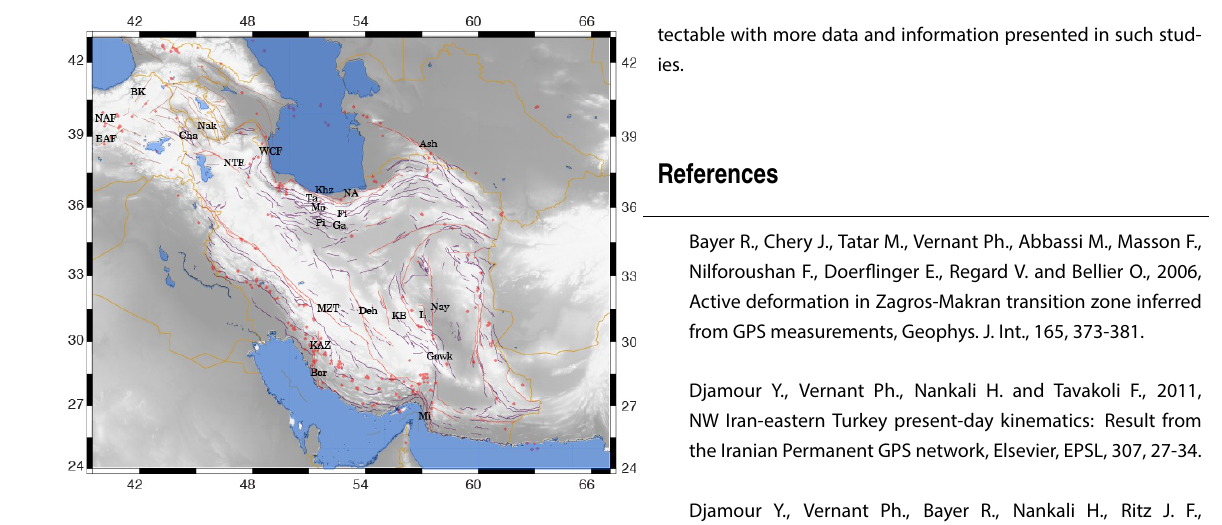
Figure 6. The map of the noteworthy fault zones and major earth- quake locations (magnitude greater than 5) in the